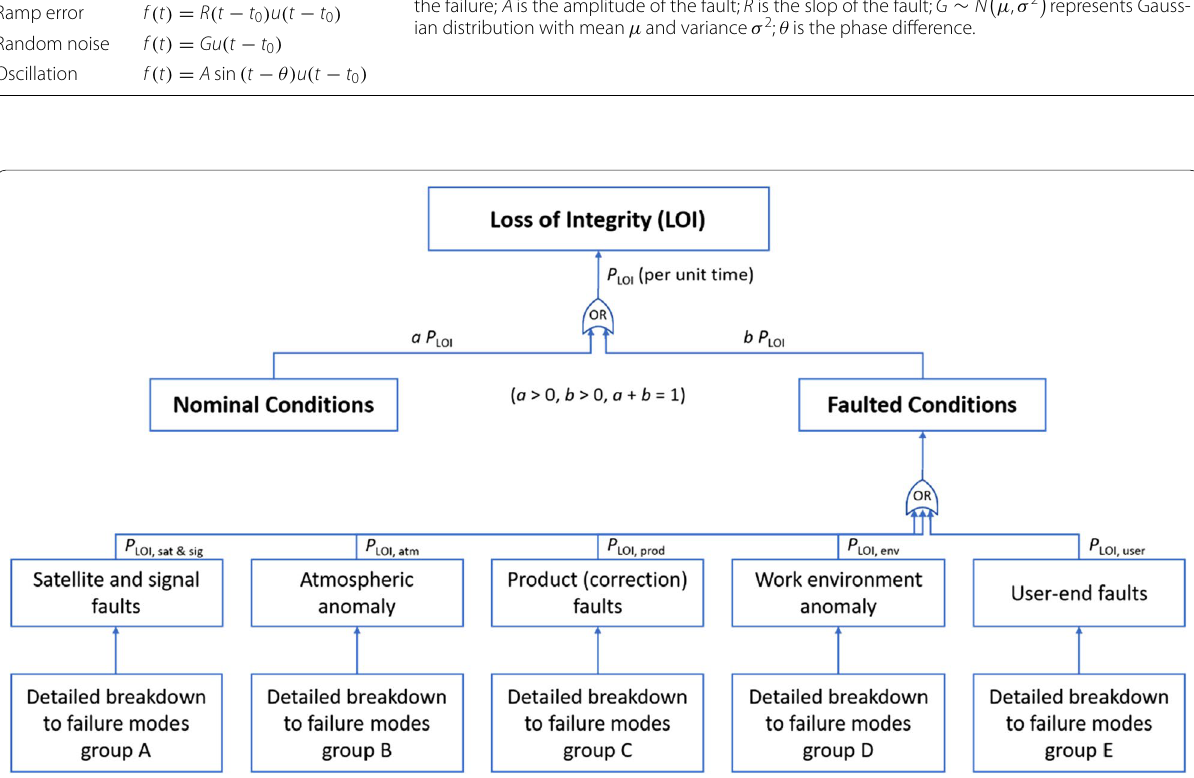
Fig. 1 Integrity fault tree example; P LOI : probability of loss of integrity; P LOI, sat & sig : P LOI related to satellite and signal faults; P LOI, atm : P LOI related to atmospheric anomaly; P LOI, prod : P LOI related to product (correction) faults; P LOI, env : P LOI related to work environment anomaly; P LOI, user : P LOI related to user‑end faults. See Table 1 for detailed failure modes in each group. Adapted from “Quantifying Integrity”, by Hexagon Positioning